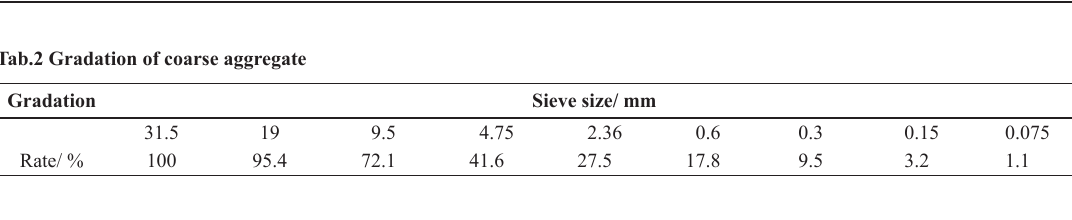
Tab.3. Mechanical performance of different mixes cement stabilized graded